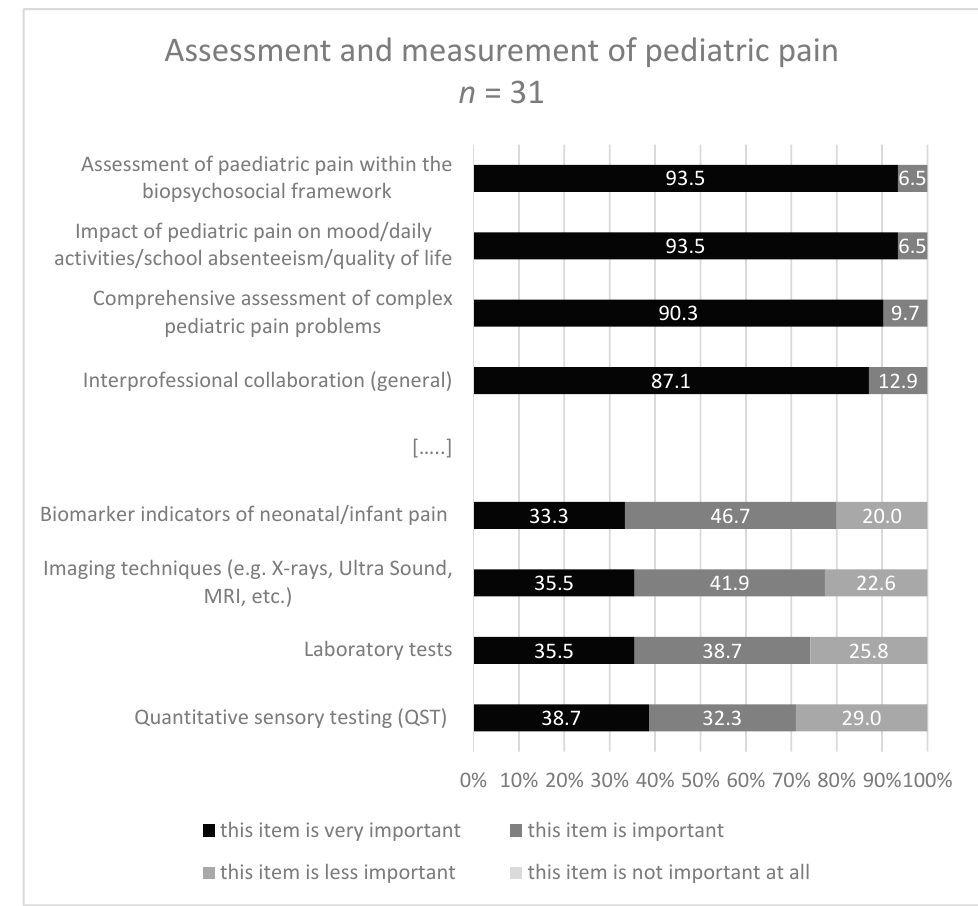
12 of 22 Figure 3. Response categories with highest/lowest accordance in area 1 (Multidimensionality). […..]: omission of items in the medium range The experts were also invited to add suggestions for further contents for this area. Once again, the biopsychosocial framework was in the foreground and the consider- ation of childhood development trajectories was mentioned, e.g.,: “… Attachment and role of developmental trauma on development (including how this impacts threat detection) …” (#352; OT) “… vulnerable populations (indigenous, remote and rural regions, co-morbid mental health, in justice systems; socially dislocated) ” (#225; PT) “… Yes—general developmental trajectories, underlying neurodevelopmental disorders and their interaction with persistent pain disorders, e.g., Autism …” (#352; OT) Within the second area ‘Assessment and measurement of pediatric pain’ the content ‘unidimensional tools for pediatric pain intensity’ occurred most frequently (48.3%) in the